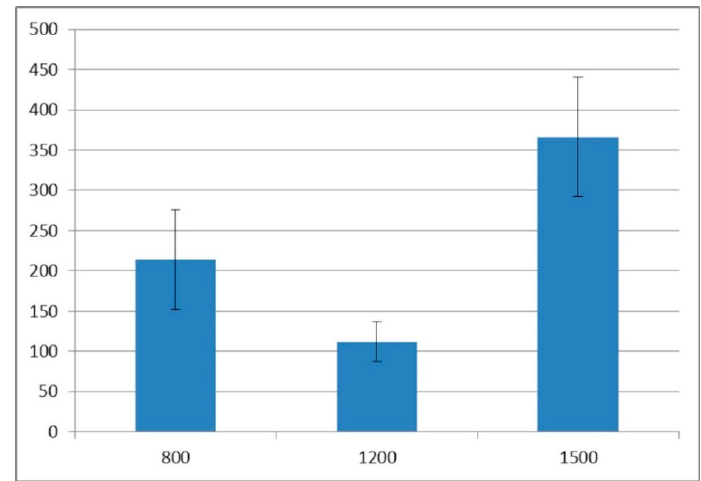
Figure 8. The thickness of the damage zone in the tested drilling speeds [µm].